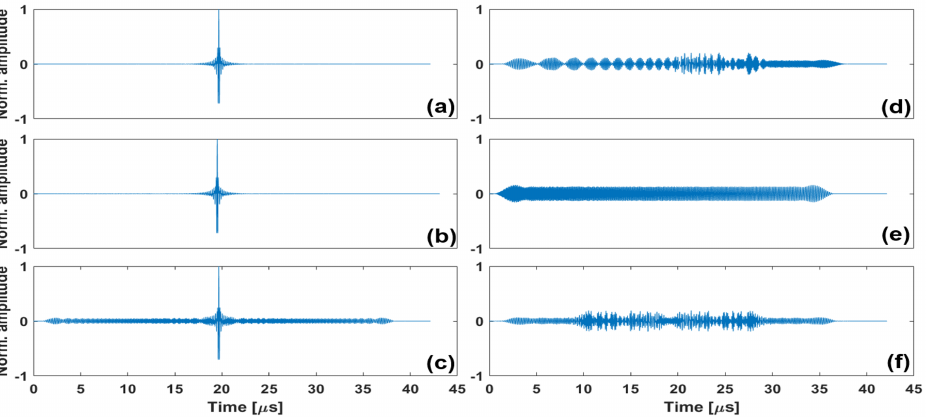
Figure 5. ( a – c ) Results of compression of the waveforms e 1 ( t ) , e 2 ( t ) , and e 3 ( t ) using the filters f 1 ( t ) , f 2 ( t ) , and f 3 ( t ) , respectively. ( d – f ) Crosstalk noise (realization of ζ 1 r ( t ) , ζ 2 r ( t ) , ζ 3 r ( t ) in Equation (20)) generated during the compression of the waveforms e 1 ( t ) , e 2 ( t ) , and e 3 ( t ) ,